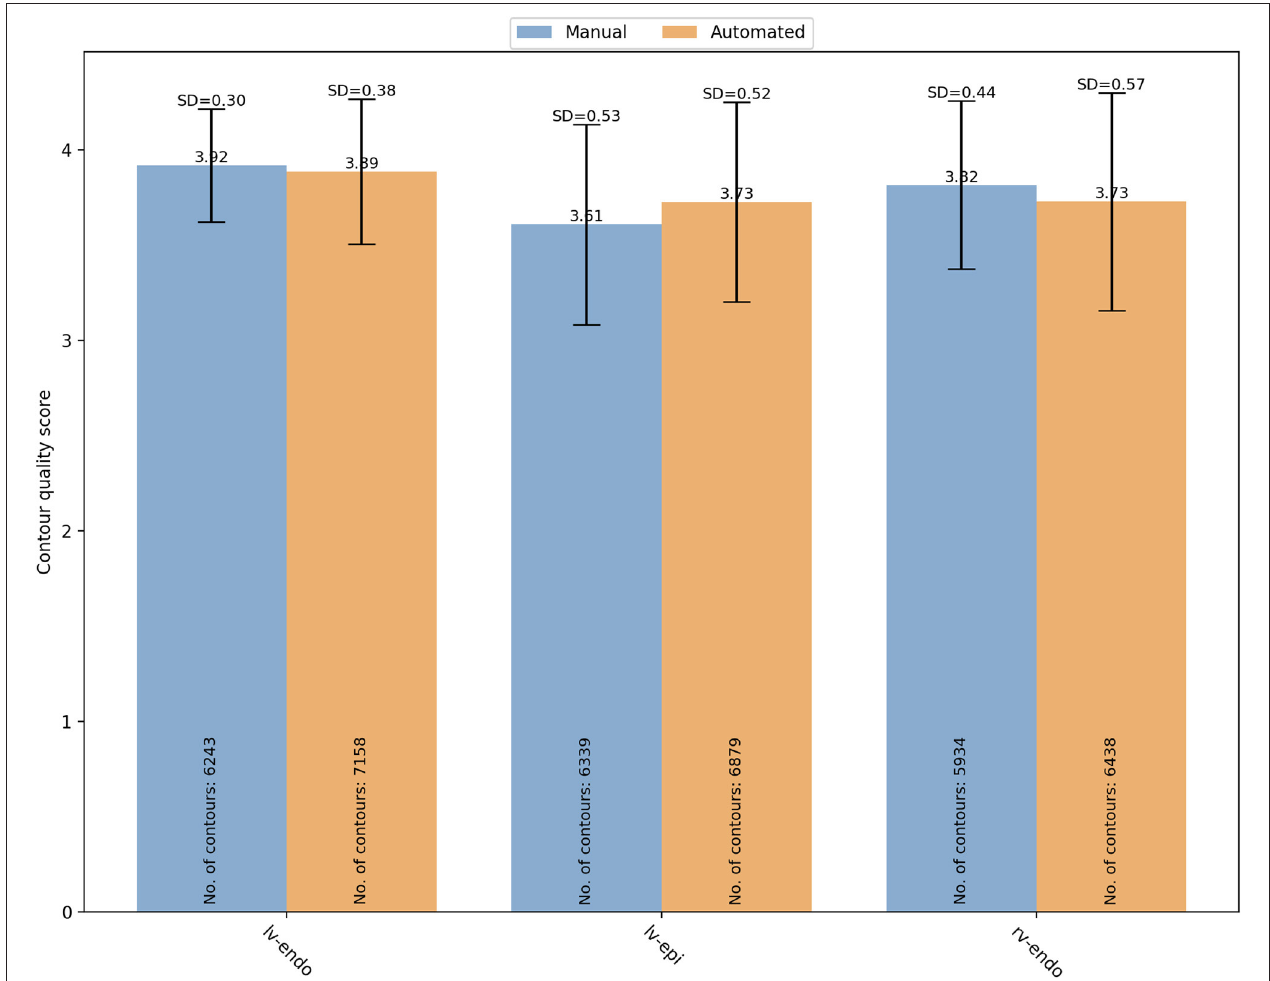
FIGURE 5 | Overall mean quality scores for LV endocardial, LV epicardial and RV endocardial contours obtained from manual (blue) and automated (orange) segmentation. LV, left ventricle; RV, right ventricle; SD, standard